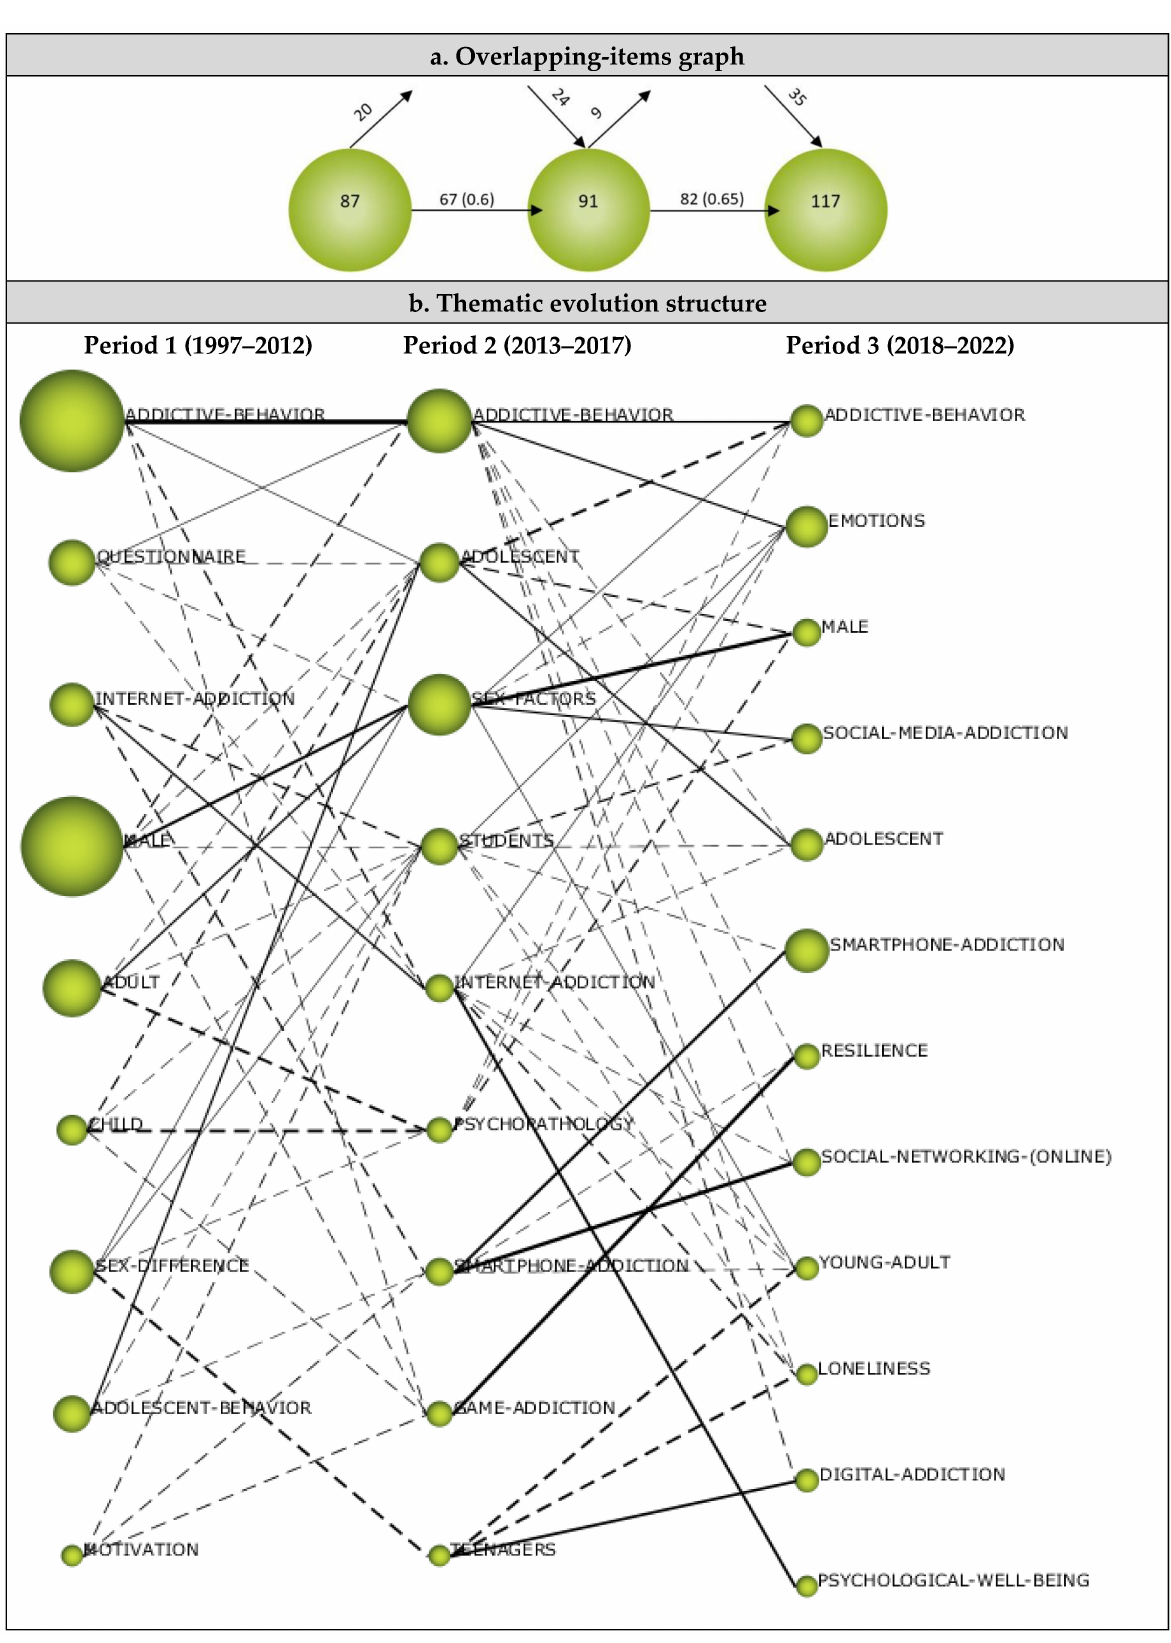
Figure 10. ( a ) Overlapping map and ( b ) thematic evolution